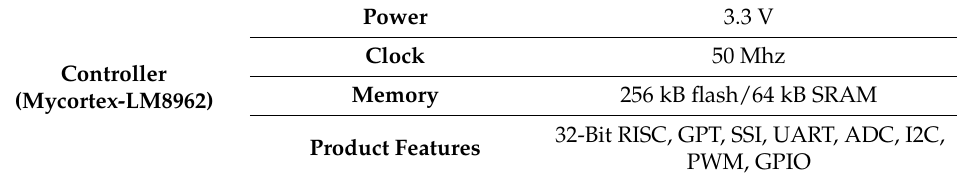
Table 4. Distance and angle